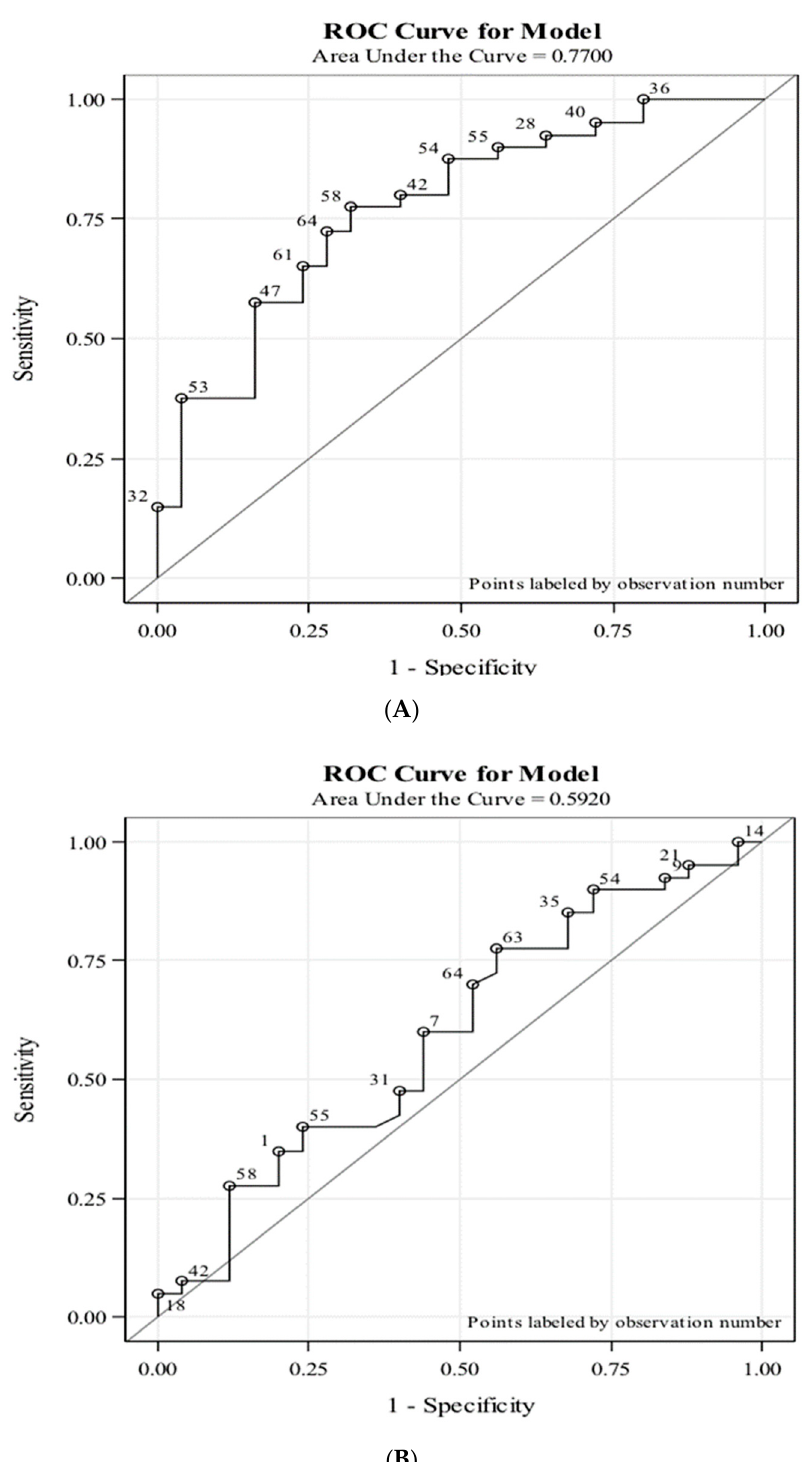
Figure 4. Receiver operating curve (ROC) for 3D telomere analysis of pre-operative CTCs from 65 intermediate risk prostate cancer patients compared to their prostate specific antigen (PSA) values. ( A ): ROC curve for 3D telomere profiling of CTCs. ( B ): ROC curve for PSA. The y axes display the sensitivity and the x axes display the specificity of the assays.